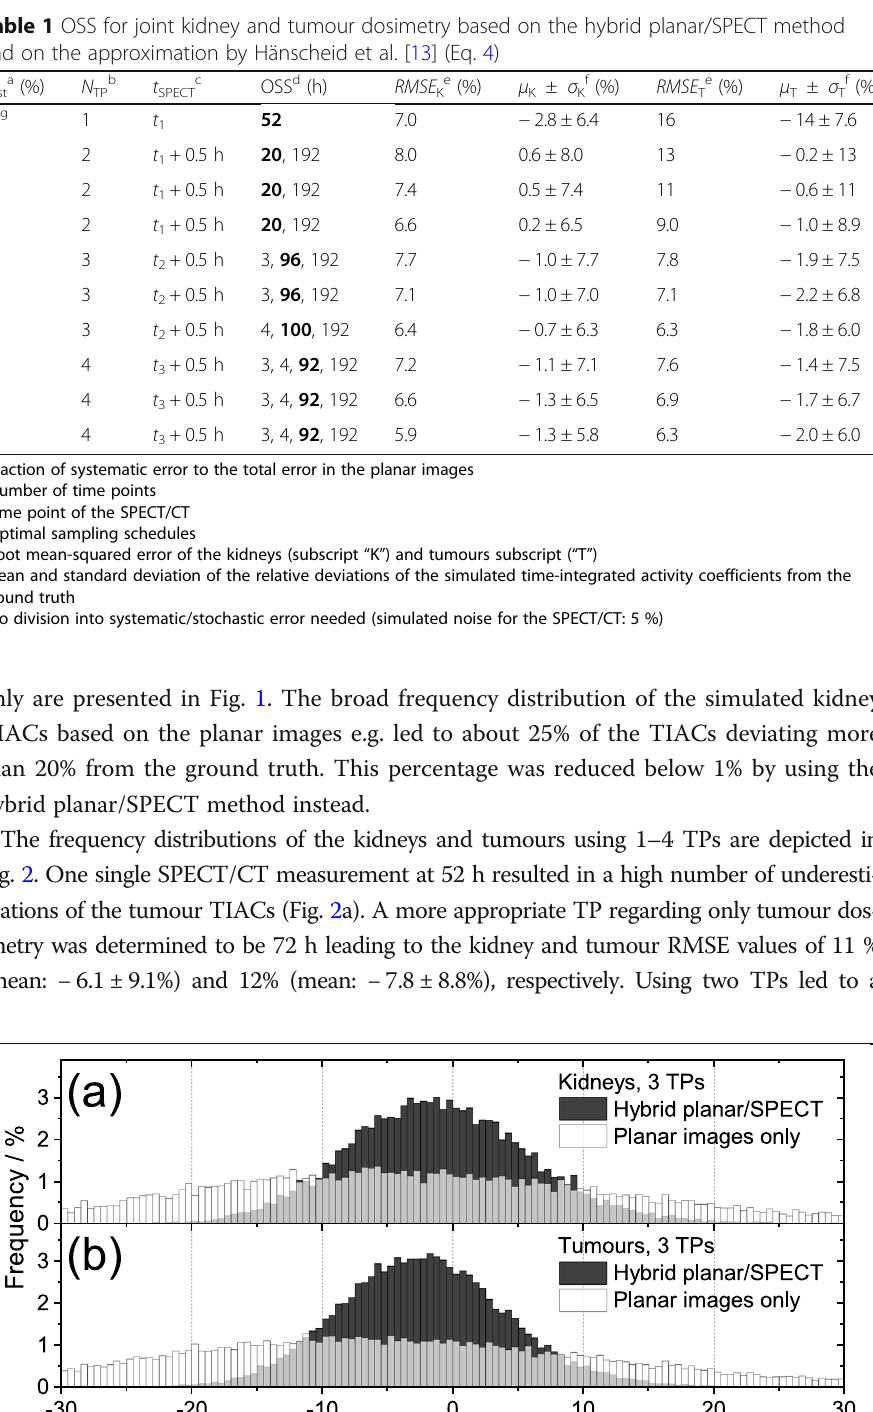
Fig. 1 Comparison of the deviations between the simulated TIACs and the ground truths considering a the kidneys and b the tumours using the hybrid planar/SPECT method (dark grey) and planar images only (white) with three time points (TPs). For the hybrid planar/SPECT method, the TIACs were determined using the optimal sampling schedule of 3, 96 and 192 with t SPECT = t 2 +0.5 h (Table 1). The used optimal schedule for dosimetry based on planar images was 20, 28 and 192 h (Additional file 1: Table S1). The systematic error of the simulated activity values based on planar images was assumed to contribute 50% to the total error